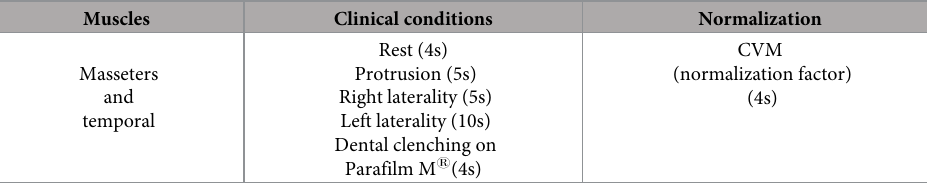
Table 9. Electromyographic protocol of postural